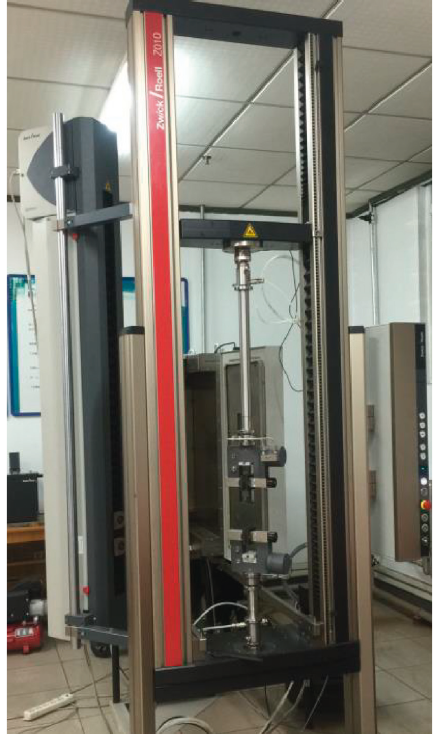
Figure 5: The Zwick/Z100 test